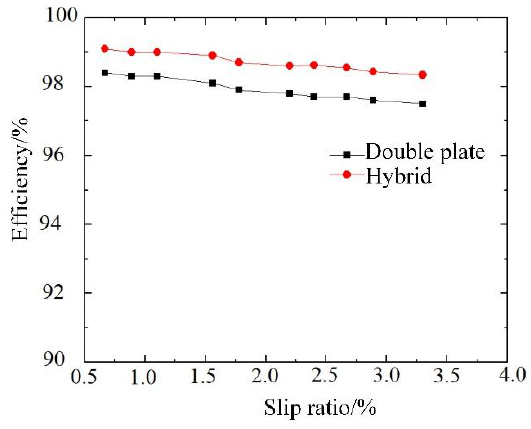
Figure 9. Prototype efficiency comparison chart.